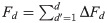
Solutions of the controlled SIR model vs. simulated data.Comparison of g(t) and I(X) obtained numerically (solid lines) and from simulated daily fatalities (diamonds). See Eq (2) for the effective reproduction factor g = g(t) and Eq (16) for the XI representation. Simulated daily and total fatalities were obtained from active cases as ΔFd ∝ I(t = d), and Fd=∑d′=1dΔFd. Hence diamonds correspond to a points for which Xd=∑d′=1dId′. Similarly, the recovered gd are obtained from the following relation gd=(τlnId+1Id+1)·(N-XdN). Identical initial conditions have been used for all cases, X(0) = 10, I(0) = 10, R(0) = 0, g(0) = 1.5, and N = 106. See Approximate integration for details.